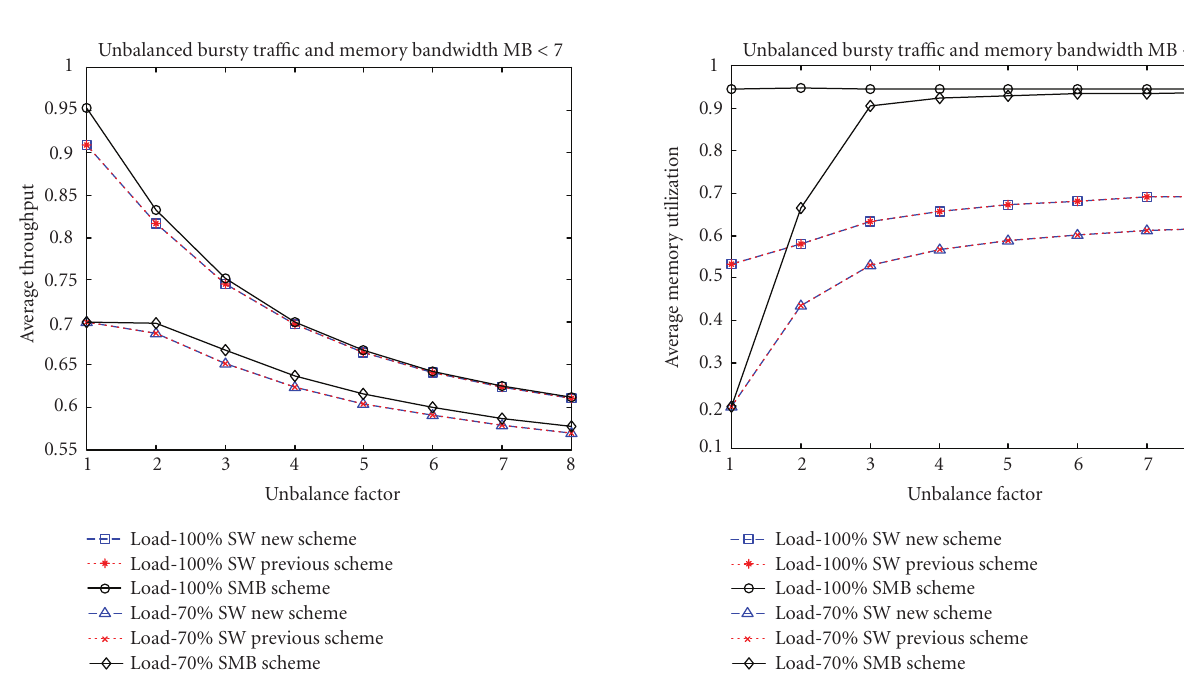
Figure 8: Average throughput with speed-up of memory modules.